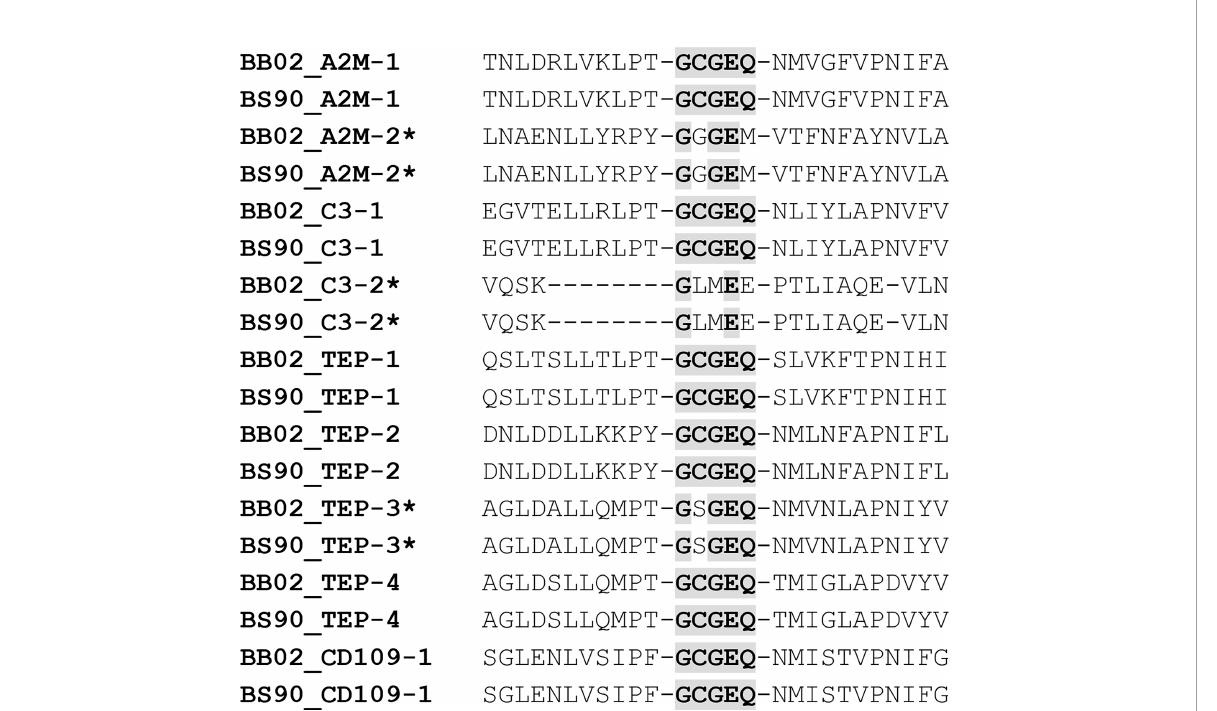
FIGURE 3 Presence of the Thioester Region (TER) in TEP Sequences. Amino acid alignment of BB02 and BS90 TEPs containing the characteristic GCGEQ TER. Conserved amino acids in the TER are highlighted and bolded, while TEPs containing one or more dissimilar amino acids within the TER are labeled with an asterisk. CPAMD8 and C3-3 were not